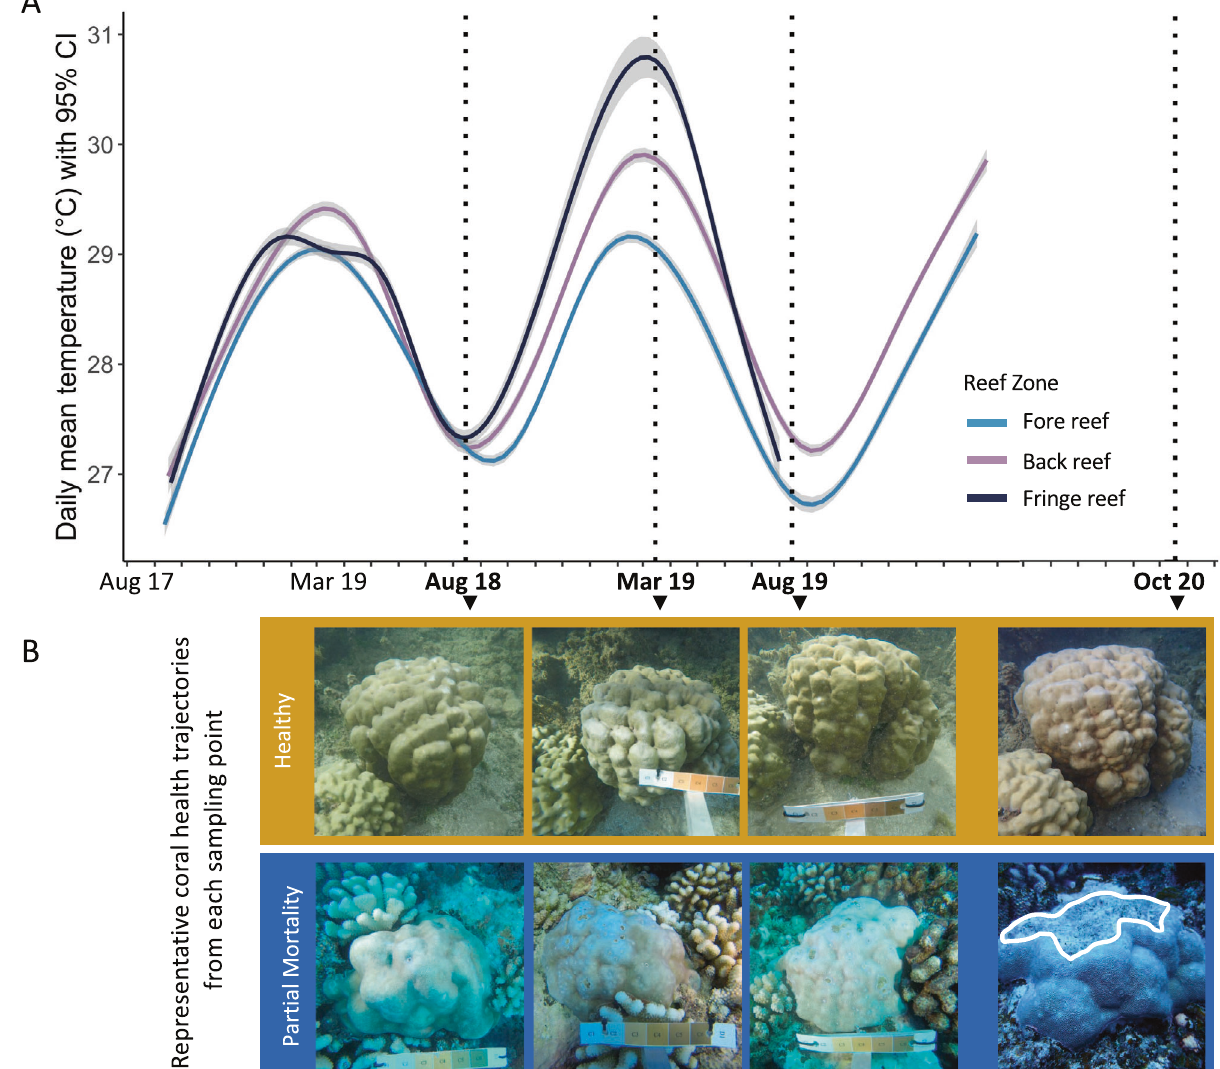
Fig. 2 Temperature fl uctuated and the health of some Porites lobata colonies changed over time on coral reefs of Moorea, French Polynesia (South Paci fi c). A Daily mean temperatures with 95% con fi dence interval over the sampling duration (temperature data collection ended prior to October 2020). B Representative coral health trajectories, depicting one colony that remained healthy at each sampling point over the study duration (orange box) and one colony that experienced partial mortality by October 2020 following bleaching in August 2019 (blue box, partial mortality outlined in